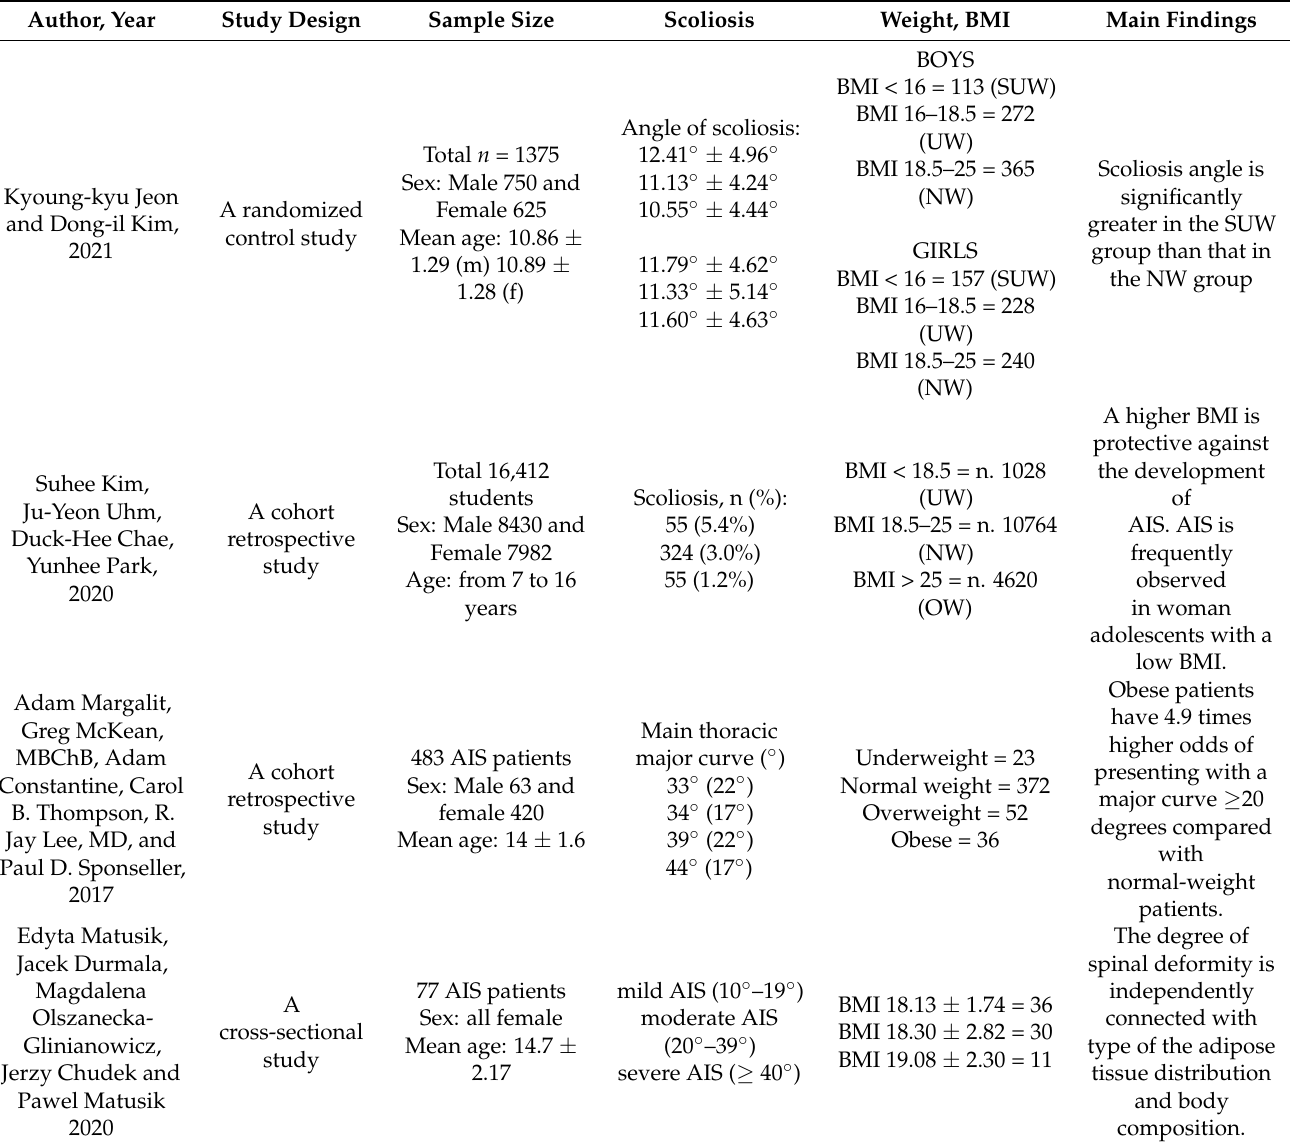
Table 3. Characteristics (topic, study design, number of patients included or number of studies if revised) and results of studies included in the scoping review on the relationship between body mass and